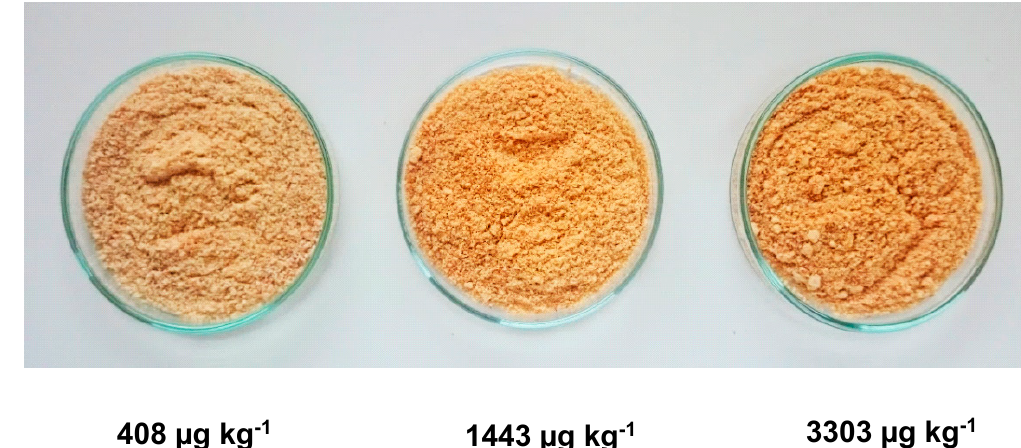
Figure 3. Photograph of the same lot of biscuits (Biscuit D) subject to different cooking temperatures. The different colors can be observed ( Δ L = 5.53 and 2.25; Δ a = 3.61 and 0.61), as well as the corresponding acrylamide levels ( Δ AA = 1035 and 1860 μ g kg − 1 ).